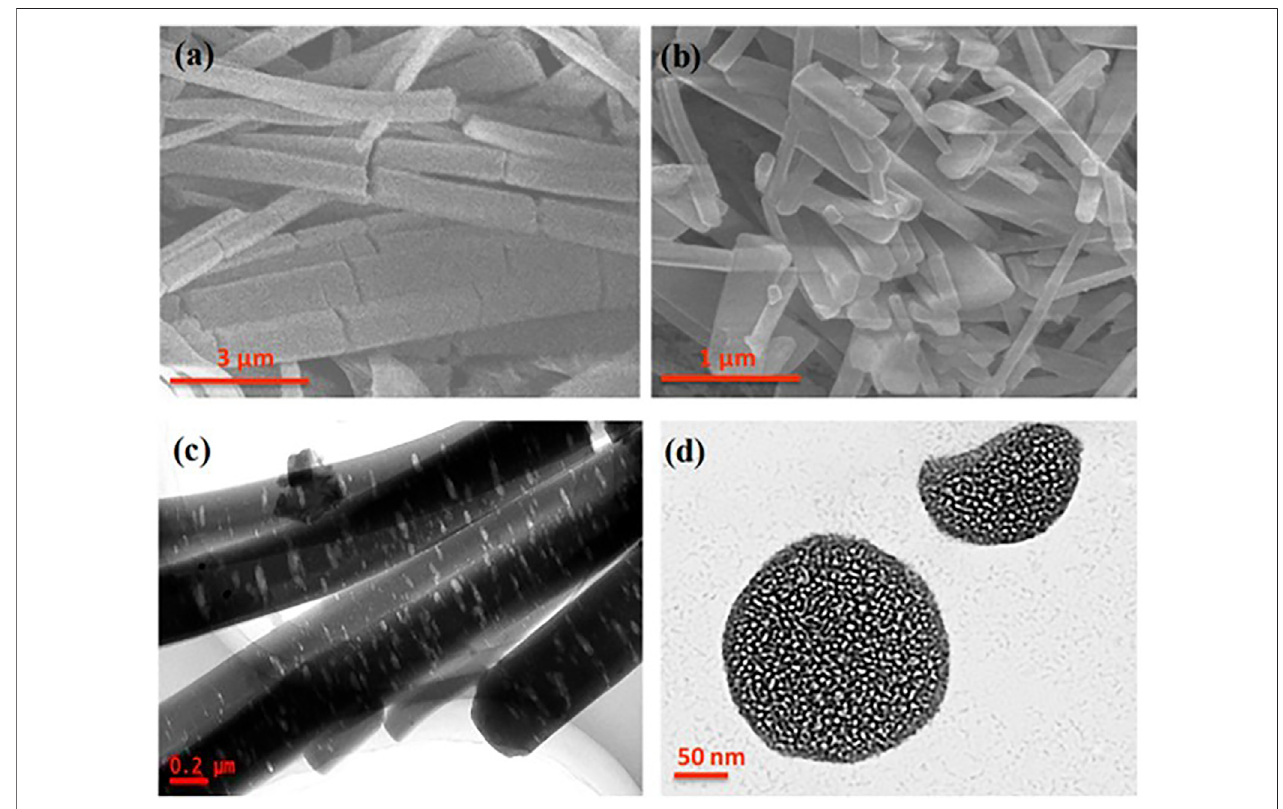
FIGURE 2 | (A) and (B) SEM image of RN-g-C 3 N 5 . (C) TEM image of RN-g-C 3 N 5 . (D) TEM image of a cross section of RN-g-C 3 N 5 . Reproduced with permission from (Wang et al.,